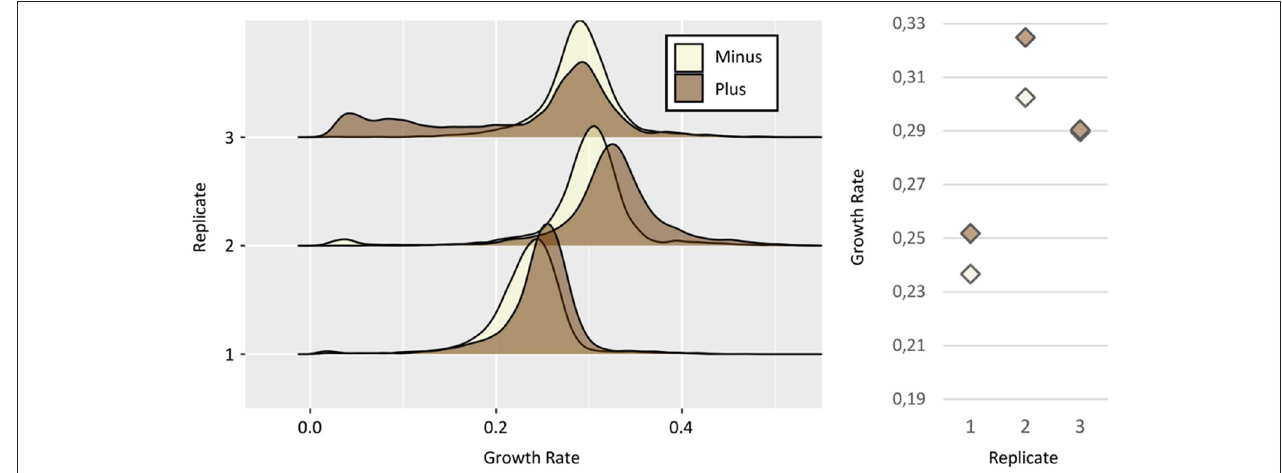
FIGURE 4 | Relationship between TPS1 expression and growth. (Left) Growth rates distributions of Minus (white) and Plus (brown) sorted subpopulations, from three independent replicates of the strain Ntd-Tps1. Growth rates calculation as in Figure 3 . (Right) Median growth rates of the distribution for Minus and Plus cells,